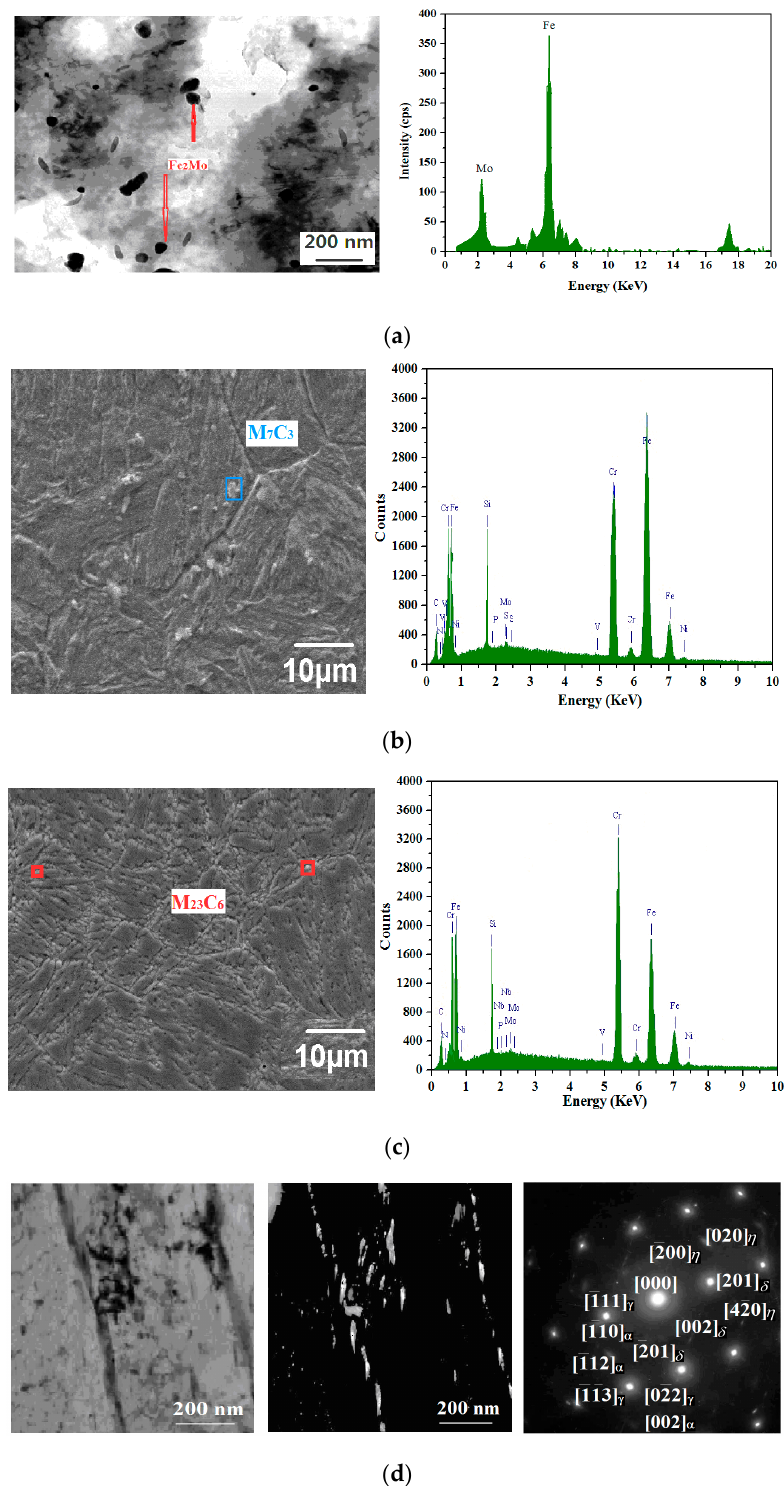
Figure 10. Phase analysis of the microstructure after various heat treatments: ( a ) TEM bright field image of the Laves-Fe 2 Mo phase after the quenching process; ( b ) microstructure consisting of ◦ C; ( c ) microstructure of α + Nb(C, N) α + Nb(C, N) + M 7 C 3 by quenching and tempering at 550 + M 23 C 6 by quenching and tempering at 650 ◦ C. ( d ) Bright-field image, dark-field image, and diffraction pattern from quenching and tempering at 650 ◦